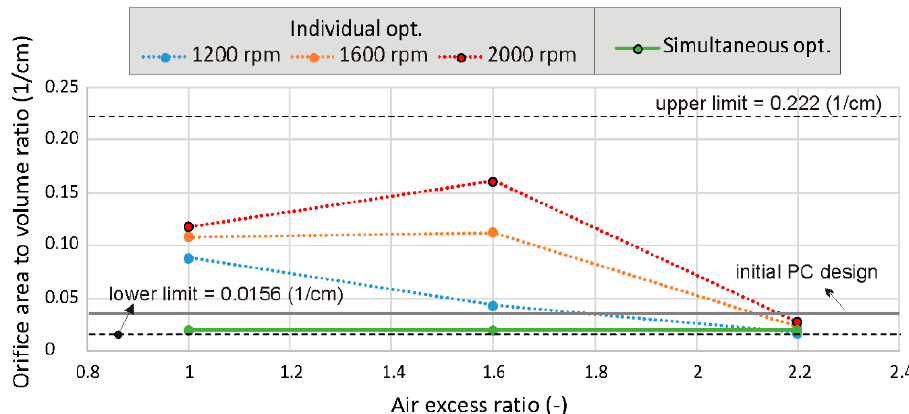
Figure 15. Optimized orifice area to PC volume ratio over individual and simultaneous optimization.